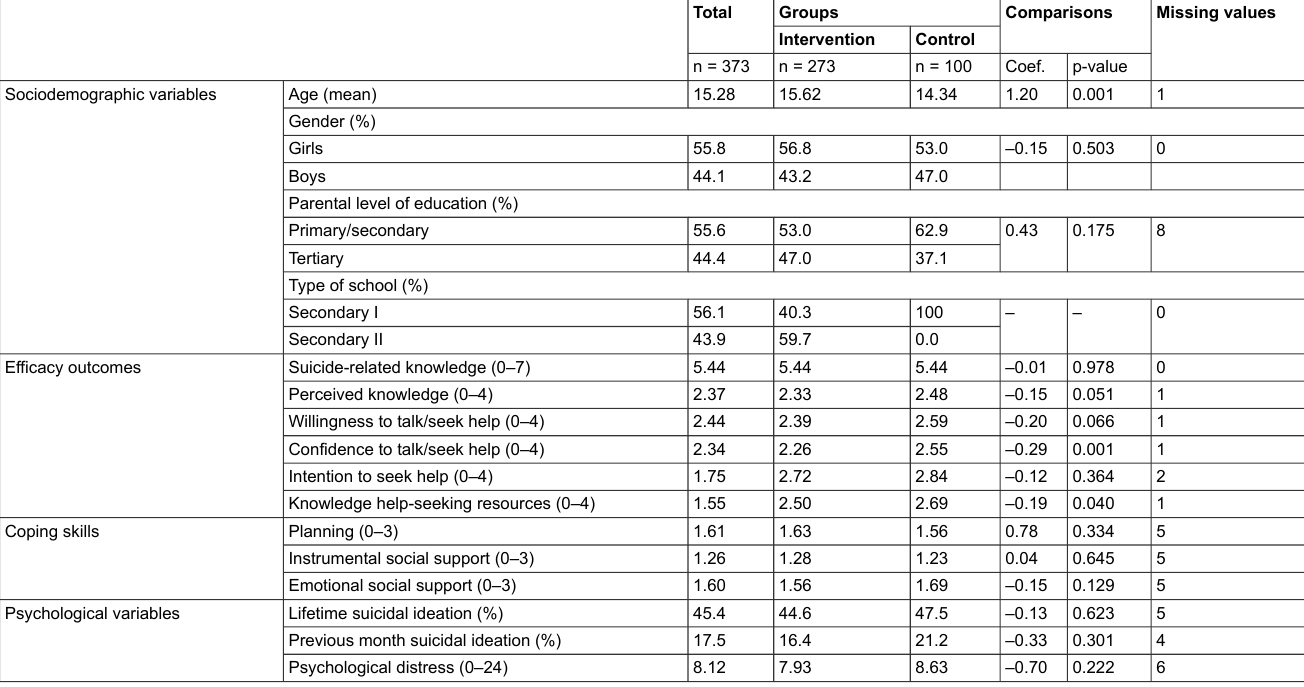
Comparisons were performed using mixed-effect linear or logistic